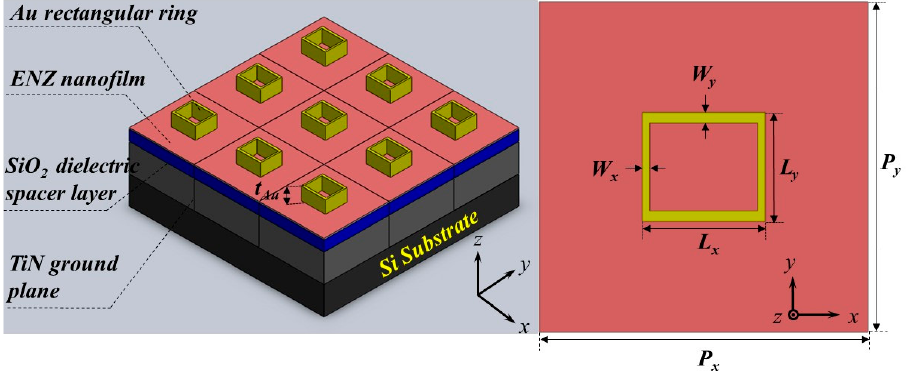
Figure 1. ( a ) Sketch and ( b ) top view of the epsilon-near-zero (ENZ)-based absorber with a top rectangular grating.